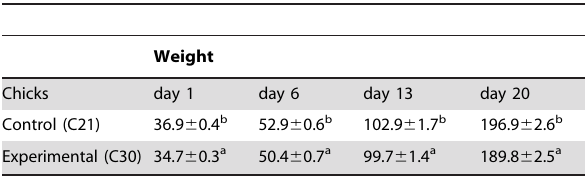
Table 3. Mean 6 SEM mass of C30 and C21 chicks from days 1 to 20.